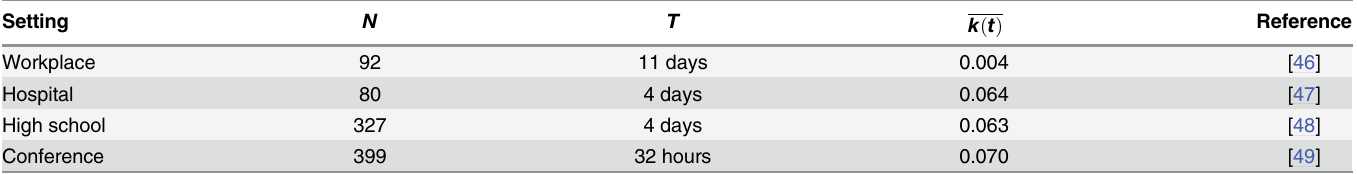
Table 1. Summary statistics for empirical face-to-face contact networks from the SocioPatterns collaboration [45]: social setting; number of nodes in the network, N ; total duration of measurements, T ; average instantaneous degree, k ð t Þ . Setting N T k ð t